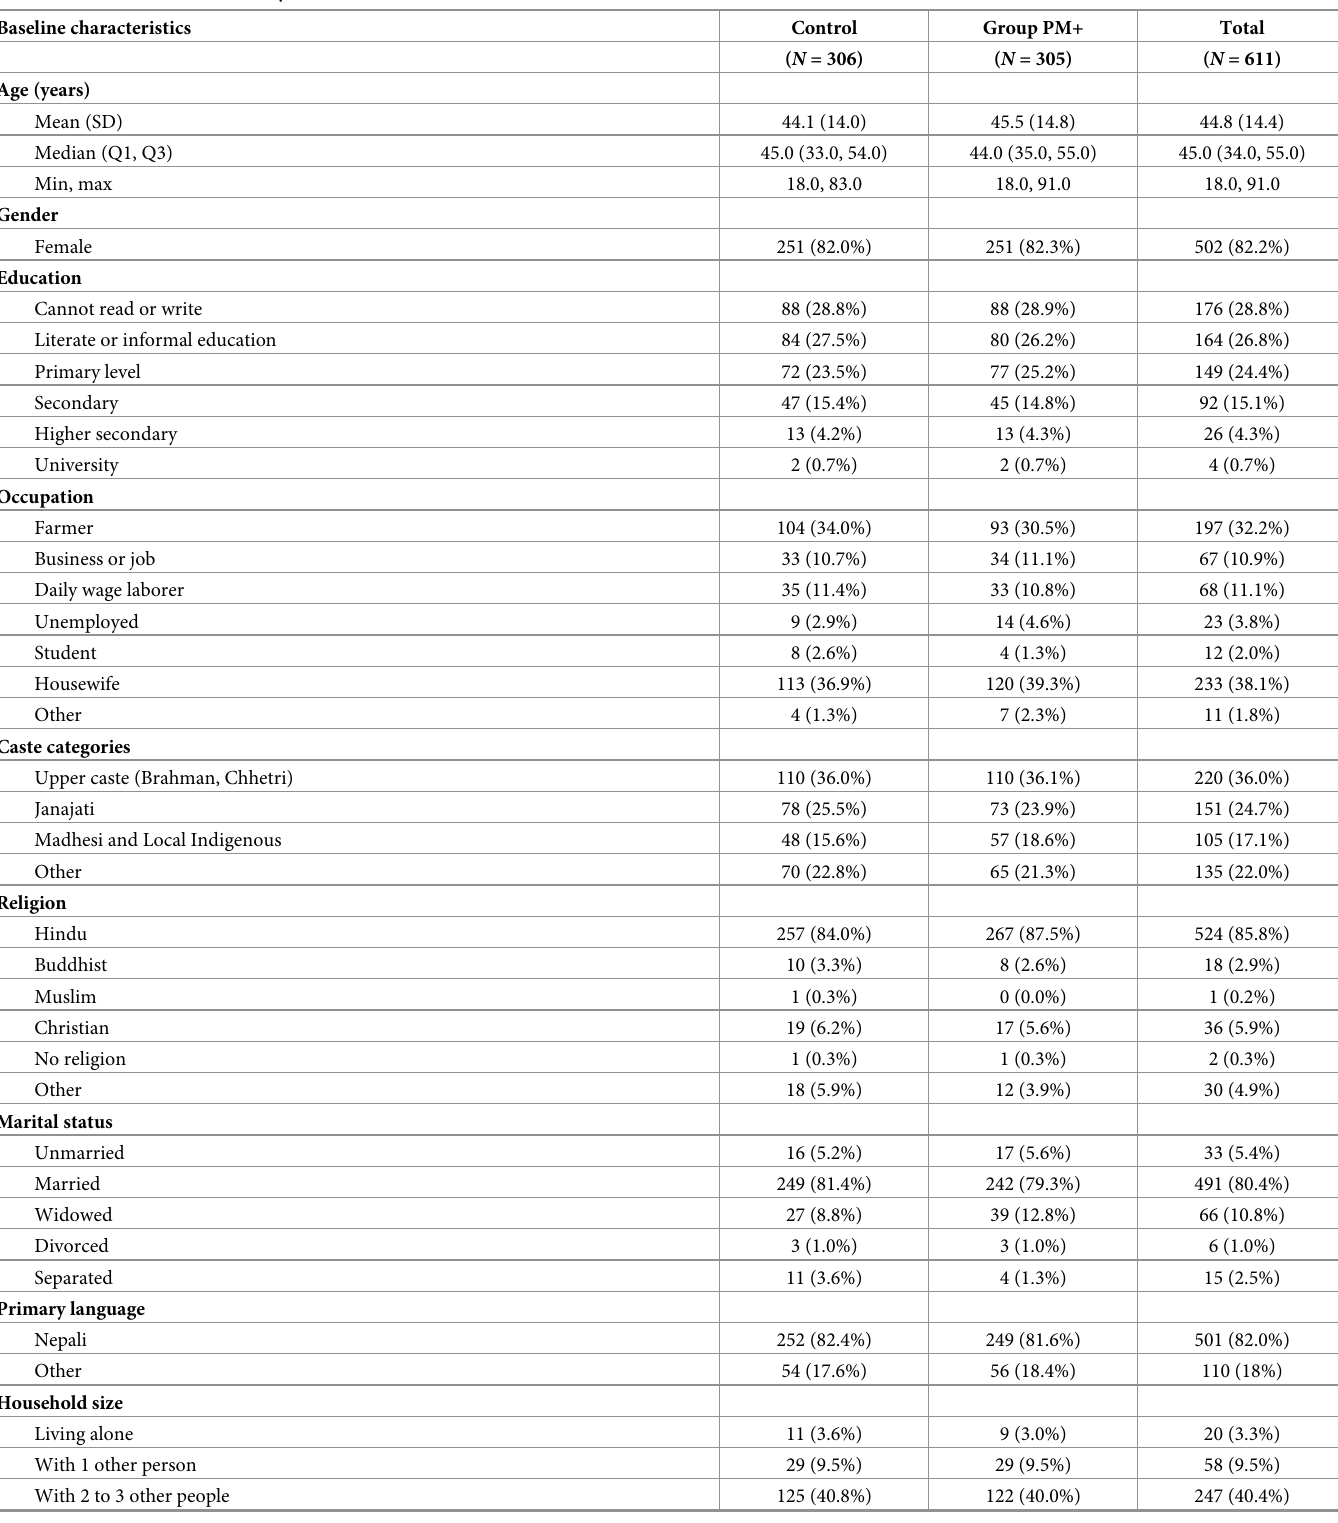
Table 1. Baseline characteristics by